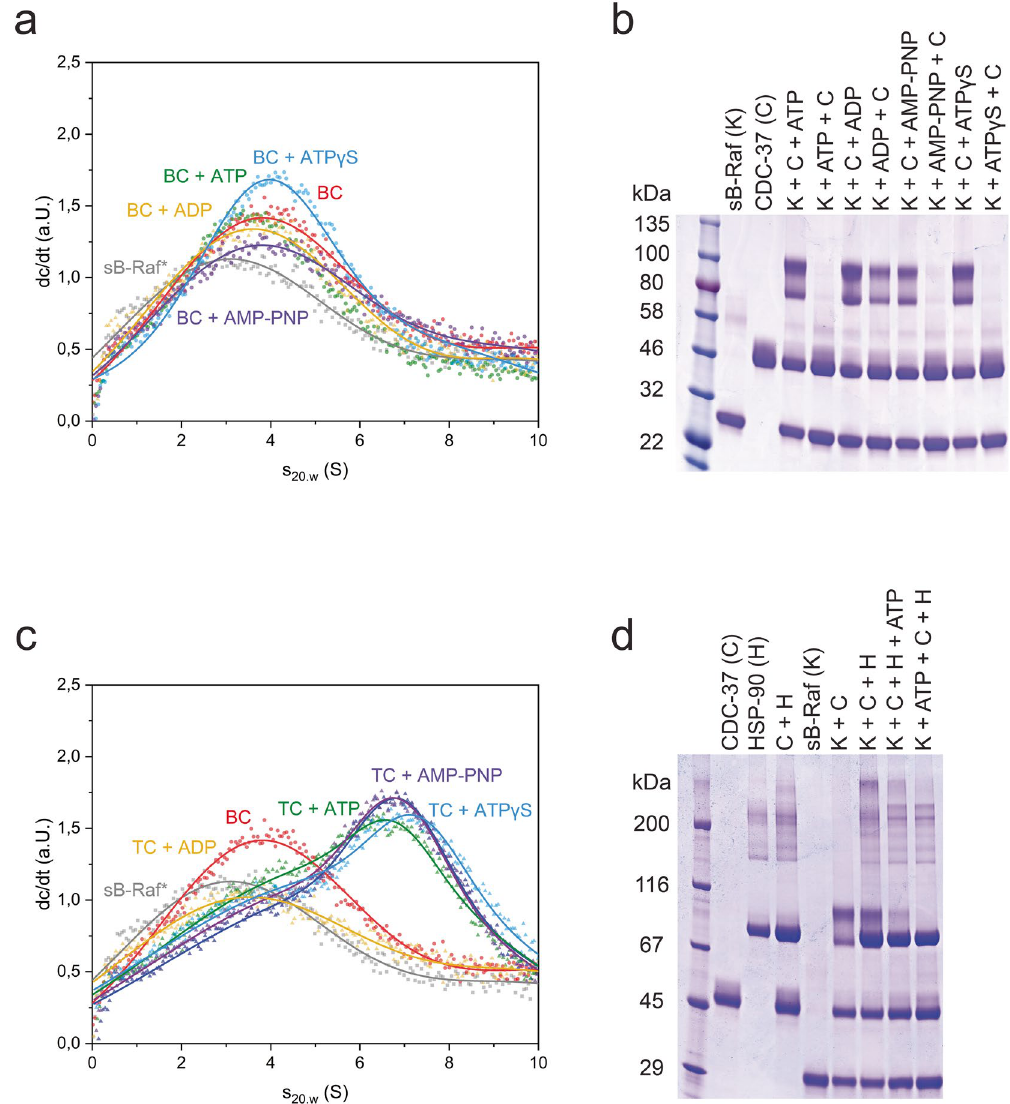
Figure 1. Influence of nucleotides on kinase complex formation. (a) Formation of sB-Raf•CDC-37 binary complex (BC) and influence of different nucleotides. (b) Influence of nucleotides on the binary